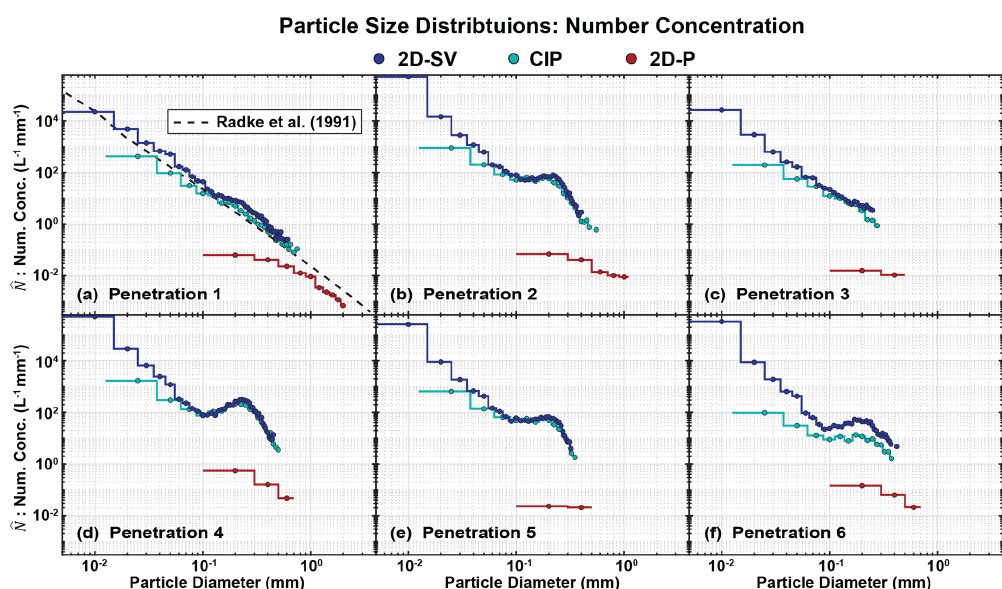
Figure 5. Size distributions of particle number concentration ( ˆ N ) for (a–f) penetrations 1–6 (Fig. 1d, Table 2). Data from the 2D-SV, CIP, and 2D-P probes indicated by the filled blue, cyan, and red circles, respectively. Number-concentration size distribution of giant ash particles from Radke et al. (1991) also plotted in (a) .